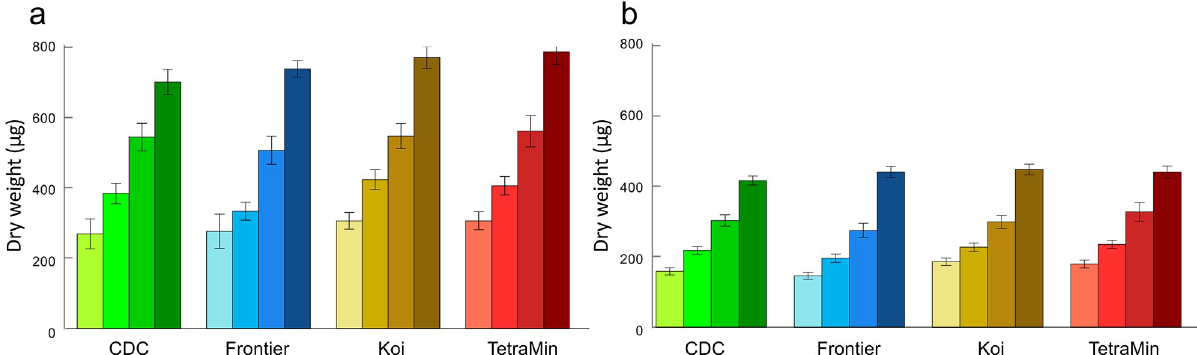
Fig 5. Adult dry weights. (a) Aedes aegypti females and (b) males. Darker shades of color indicate increasing diet levels of 8, 16, 32 and 64 mg. Error bars are 95% confidence intervals of the mean.